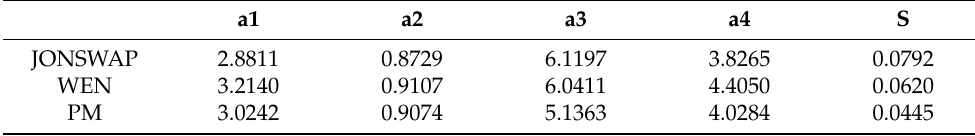
Table 3. Characteristic parameter values of freak waves of three kinds of wave